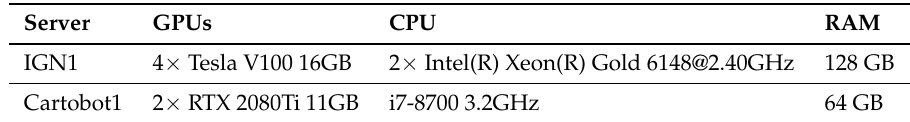
Table 1. Test servers: hardware